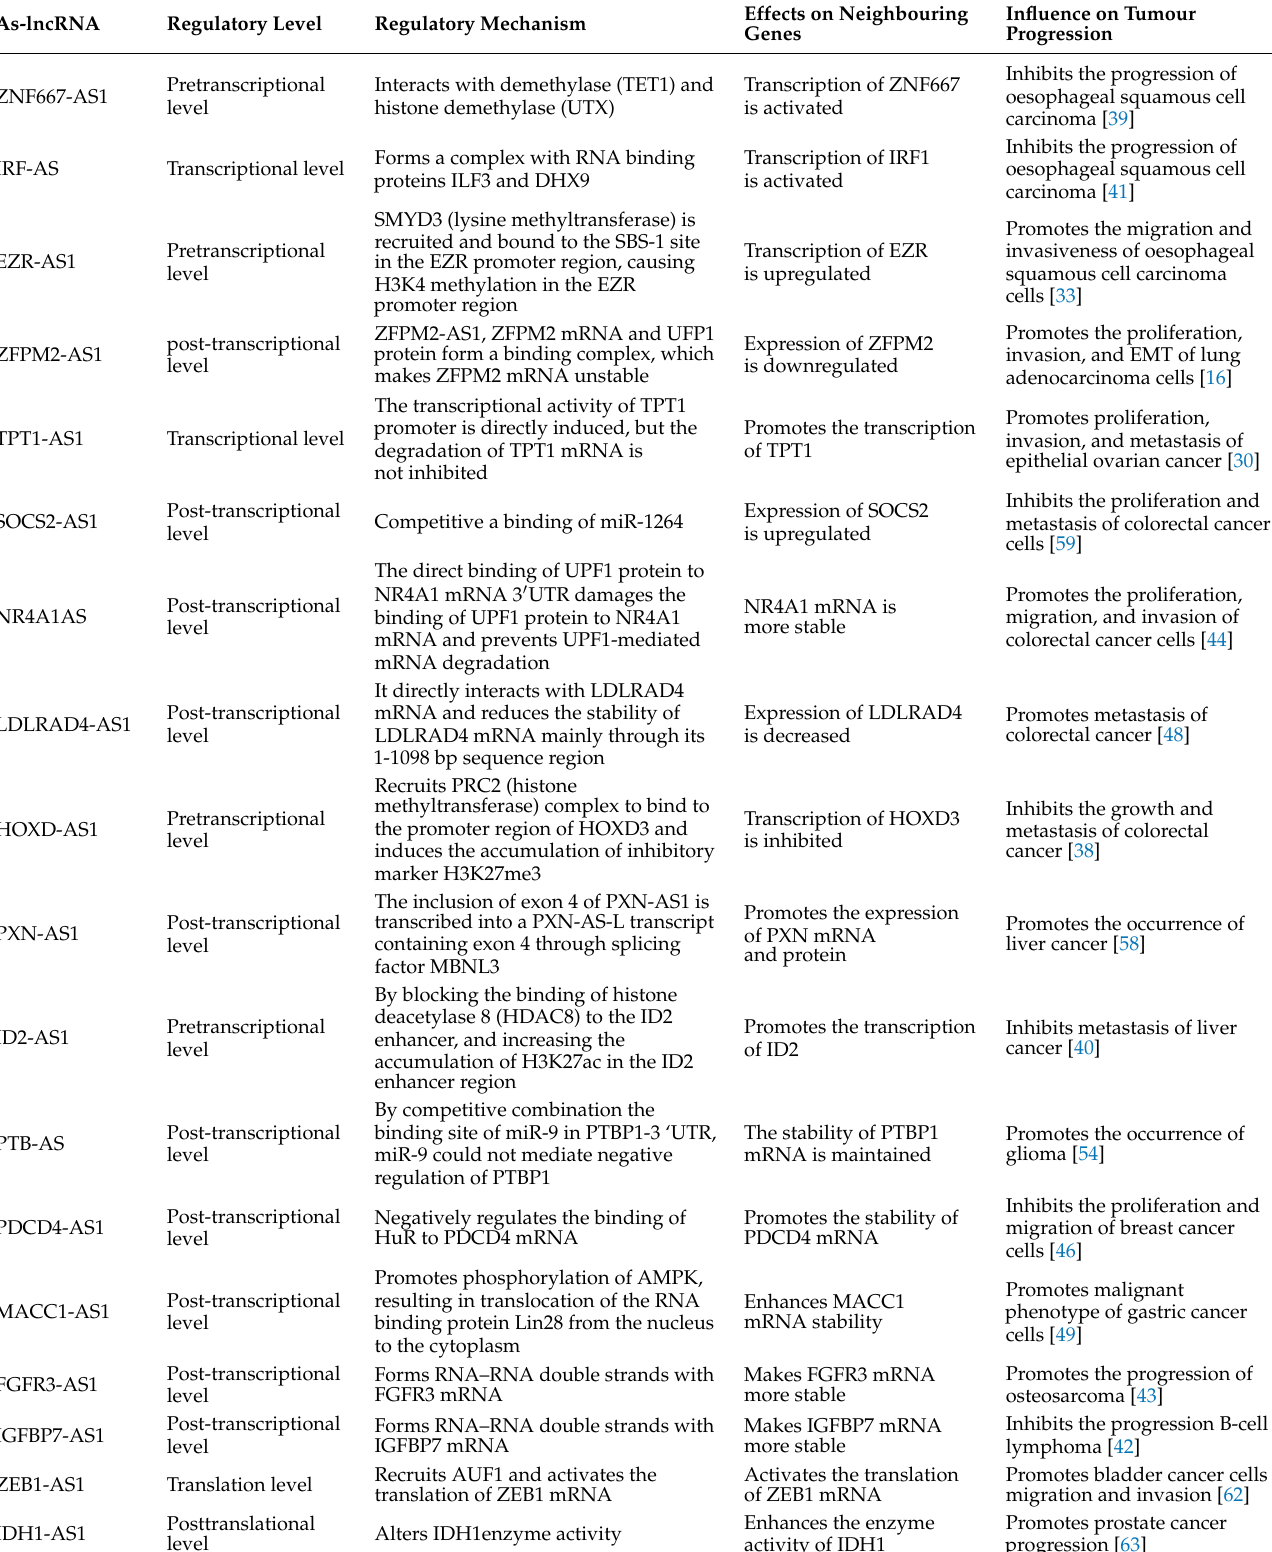
Table 2. Effects of as-lncRNAs on the occurrence and development of different types of tumours by regulating neighbouring